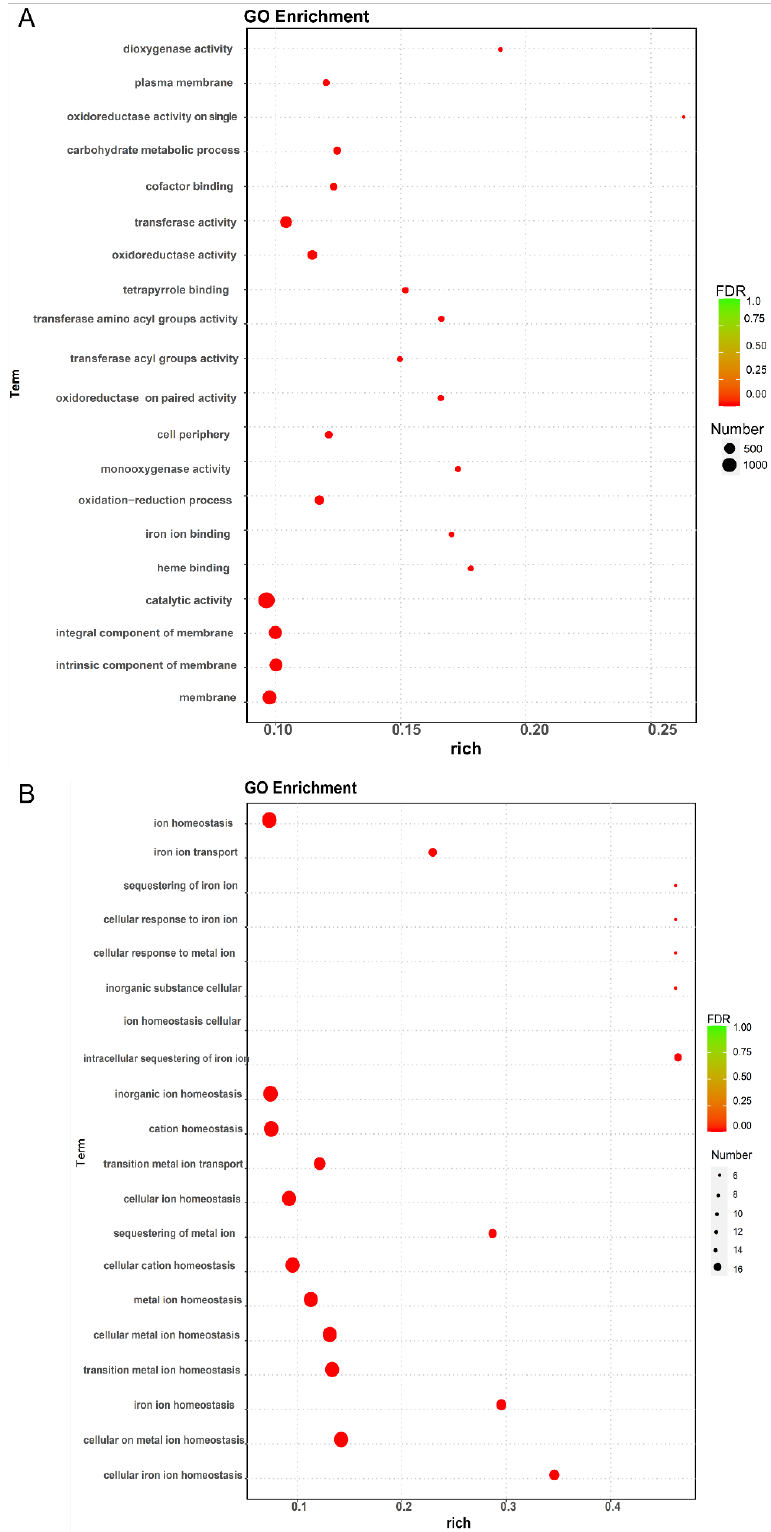
Figure 3. Bubble diagram for GO enrichment analysis. The value of FDR generally ranged from 0-1, and the closer to zero, the more significant the enrichment. The top 20 GO Term entries with the smallest FDR values, i.e., the most significant enrichment, were selected for display. ( A ) CK leaves and 300 µ M Mn leaves; ( B ) CK roots and 300 µ M Mn roots.3.7. Analysis of DEGs That Act as Conduits and